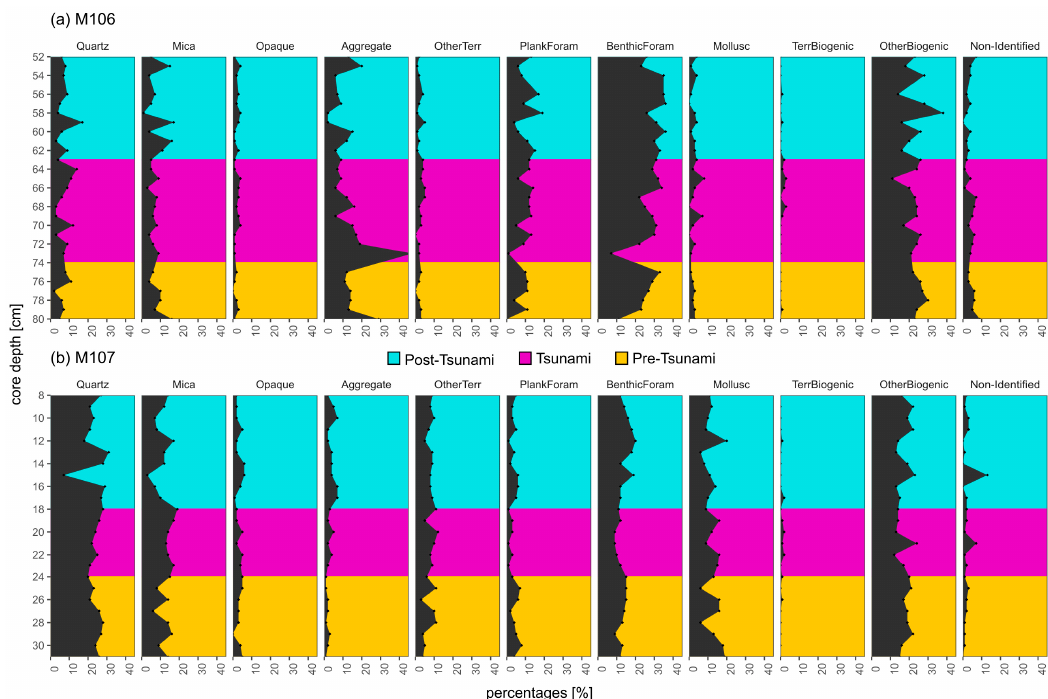
Figure 9. Sand composition (SC) in percentages along core depths of core M106 ( a ) and core M107 ( b ). A general difference in SC between core M107 and M106 is apparent: (1) In the shallower shelf core M107 higher percentages of terrigenous components (ca. 50%) are present compared to the